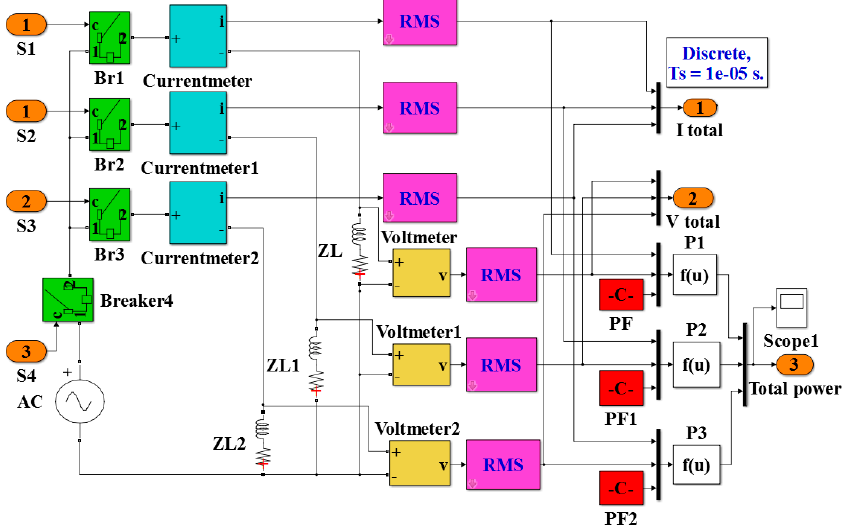
Figure 6. Simulation model of WM.